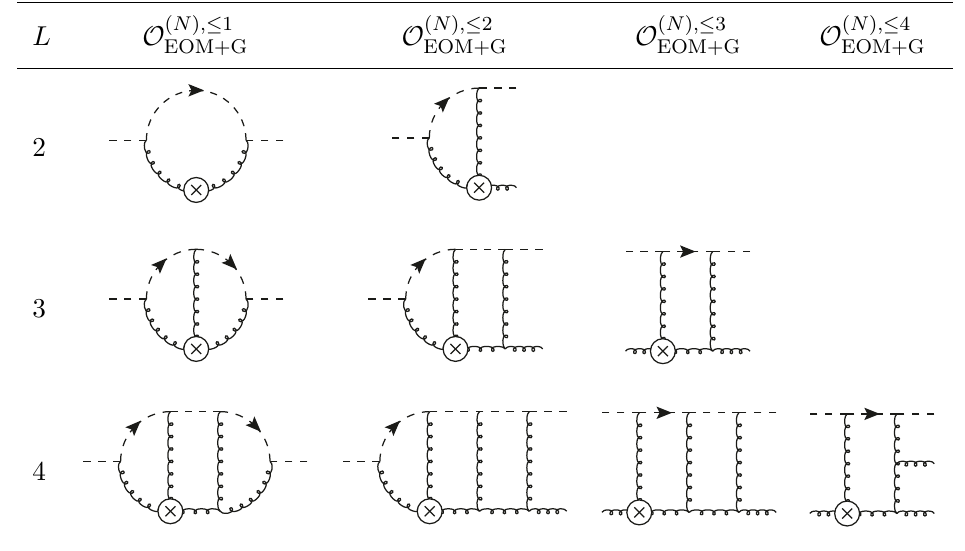
Table 6 . In the L th row the table gives examples of diagrams containing a ghost-anti-ghost pair and gluons whose UV-counterterms determine the mixing of O ( N ) — operators as required for the computation of the L -loop contribution to Γ ( N )